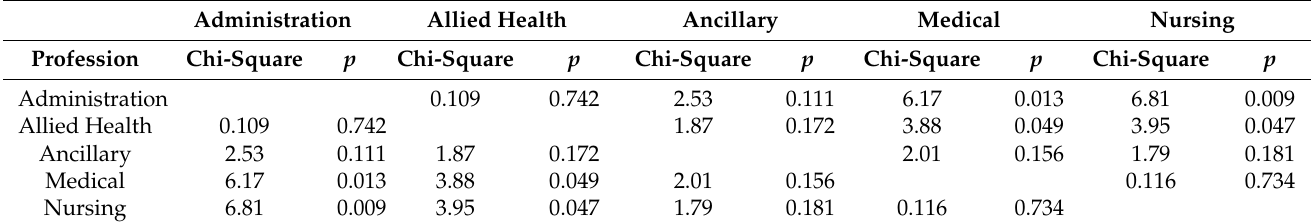
Table 3. Log rank test for Time to booster among